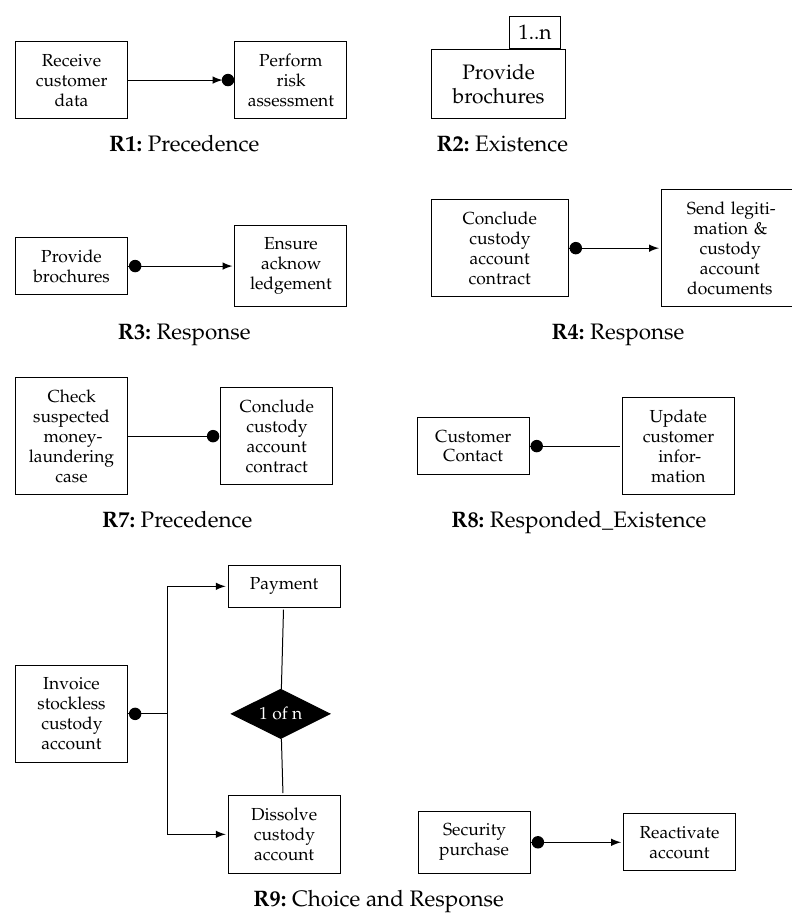
Figure 5. Formalised requirements in Declare